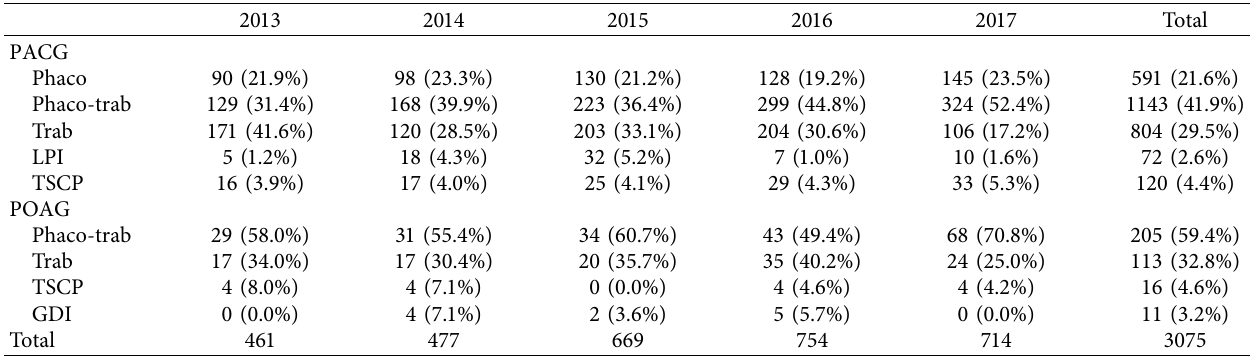
Table 3: Distribution of types of antiglaucoma surgery from 2013 to 2017.